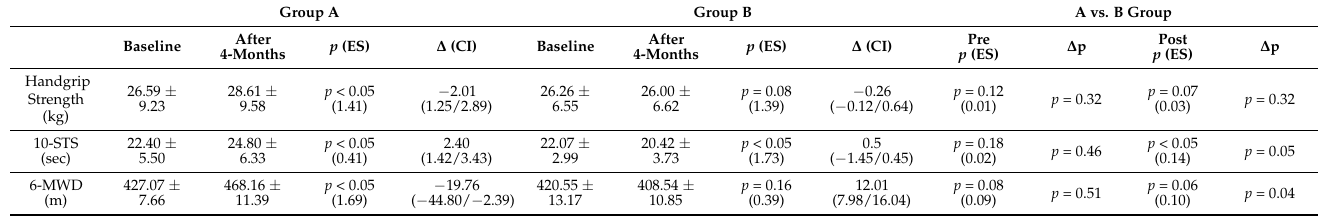
Table 2. Functional capacity analysis of the KT candidates at baseline and the end of the study. GroupB Avs. BGroup